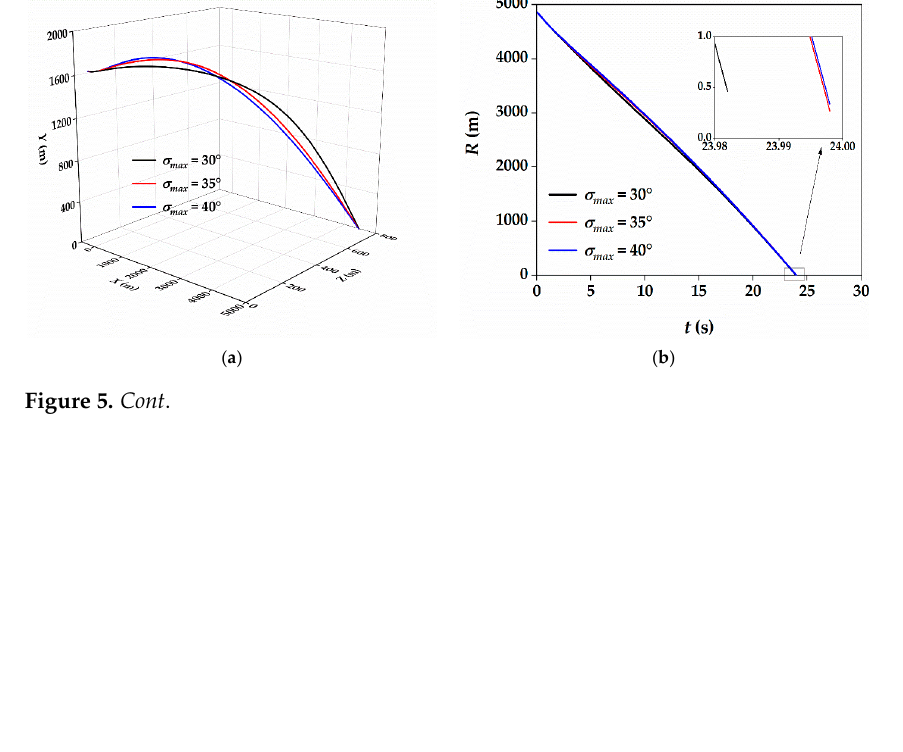
Figure 4. Simulation results under different T d . ( a ) Projectile flight trajectory; ( b ) relative distance; ( c ) impact time error; ( d ) lead angle; ( e ) velocity; ( f ) normal acceleration; ( g ) lateral acceleration.